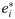
Optimal steady-state ribosome densities ei* as a function of site index i for an RFM with n = 11 sites.Data obtained by solving the translation maximization problem (Problem 1) with the homogeneous constraint (12). It may be seen that the steady-state densities strictly decrease along the chain and are anti-symmetric with respect to the center of the chain.